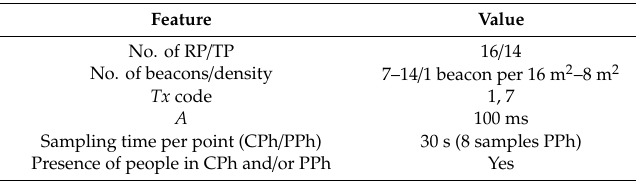
Table 25. Main features of Tests